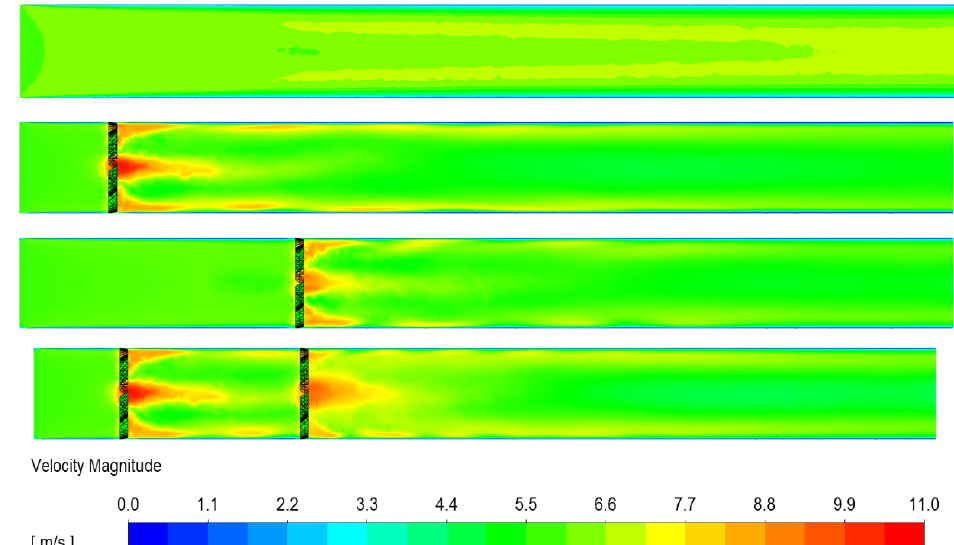
Processes 2021 , 9 , x FOR PEER REVIEW Figure 10. The temperature distribution of different mixers at 0.1 s. Figure 10. The temperature distribution of different mixers at 0.1 s.